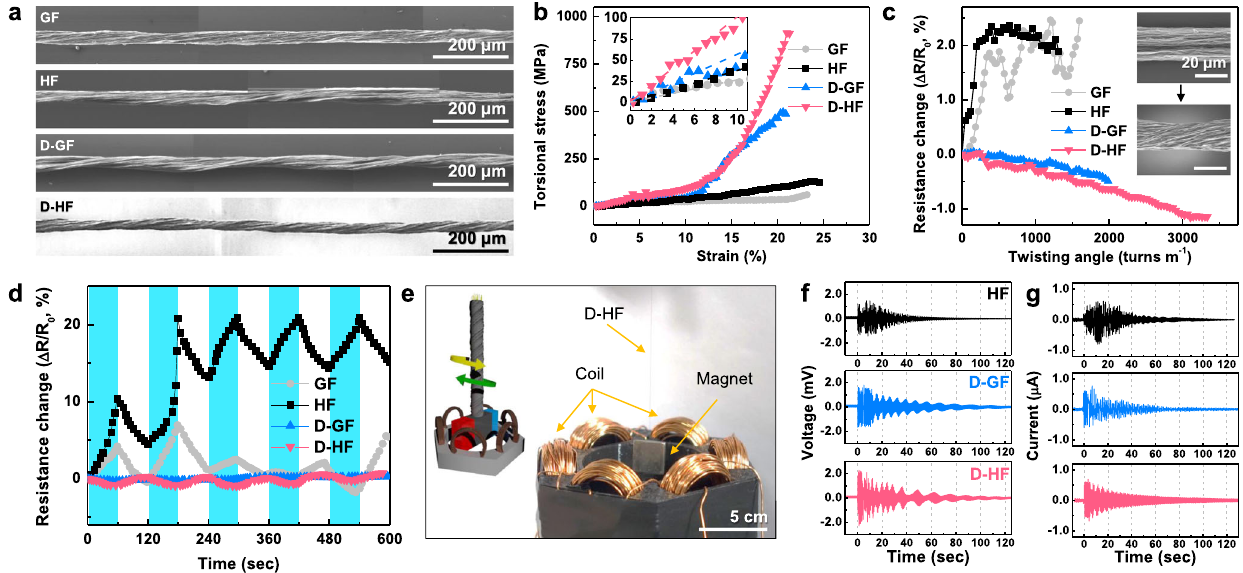
Fig. 3 Torsional performance of fi bers. a Twisted morphology of GF, HF, D-GF, and D-HF. The fi bers were twisted by two-thirds the number of breakages (GF: 1800, HF: 1300, D-GF: 1800, D-HF: 2500 turns m − 1 ). b Torsional stress – strain curves of the fi bers. The inset shows a close-up of the strain region from 0 to 10%. c Resistance change as a result of torsional deformation until the breakage points. The inset shows a shrunken D-GF fi ber by twisting. d Variation of resistance during cycle testing of repeating twisting (blue region) and untwisting (white region). e Scheme of the designed torsional current energy estimating device based on D-HF. The device contains six copper coils around the fi ber, along with a magnet. When the twisted fi ber is released, the magnet can reversibly be rotated within the surrounding copper coils to generate electricity. f Open-circuit voltage and g short-circuit current of the device with HF, D-GF, and